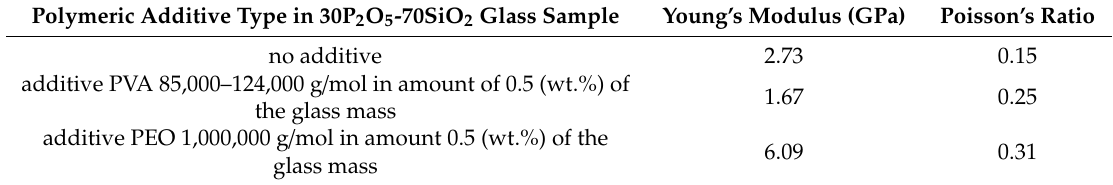
Table 3. Mechanical parameters of representative samples pertaining to various compositions of the studied